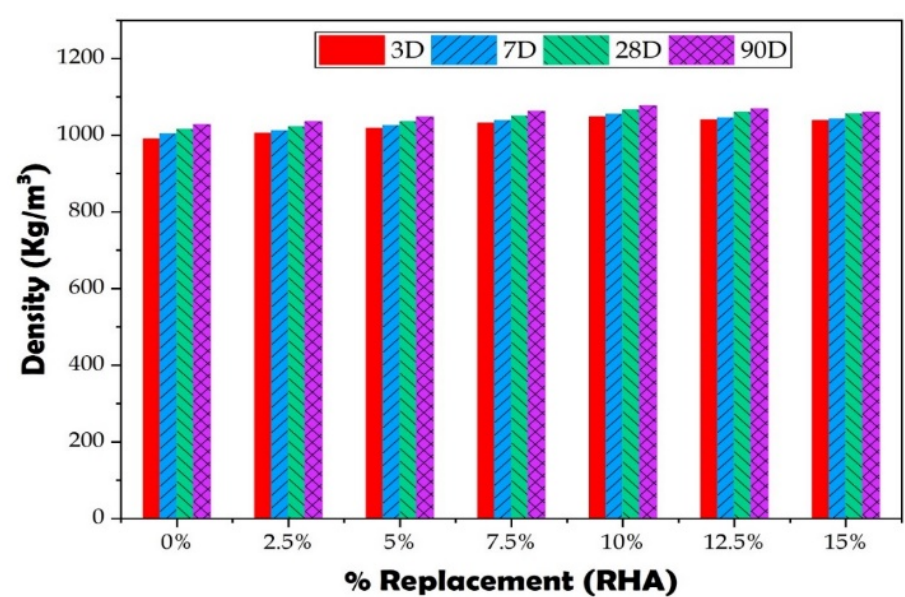
Figure 6. The density of aerated concrete (D—days).